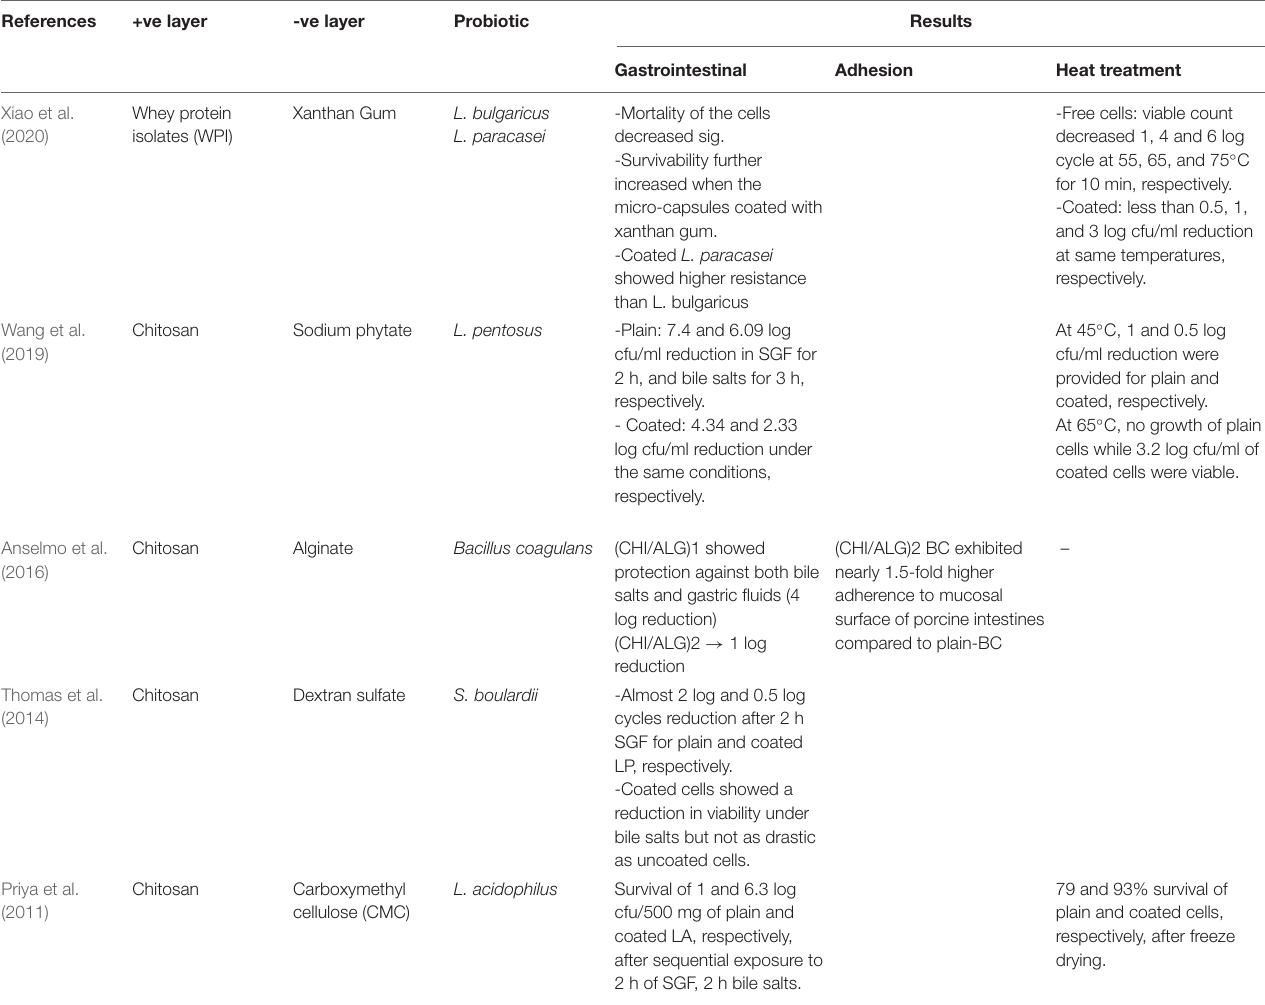
TABLE 1 | Effect of layer-by-layer of probiotics on its viability under harsh